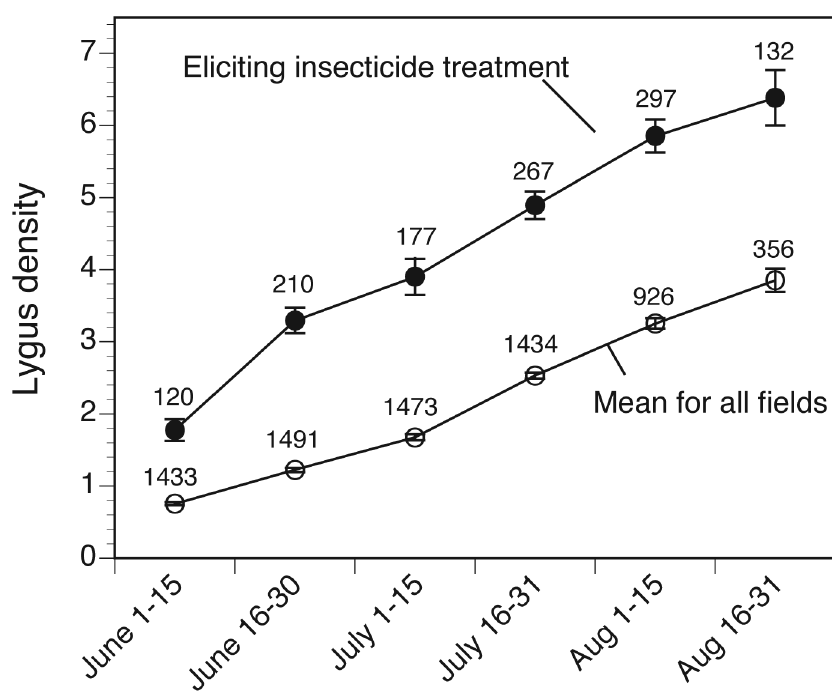
Figure 4. Insecticide use decisions and L . hesperus density. Mean ± SE density of L . hesperus that triggered the application of insecticides targeting L . hesperus (solid circles) during successive 2-week intervals during cotton’s fruiting period. Also shown for comparison are the mean L . hesperus densities observed across all fields (open circles). Numbers above the symbols are the number of fields for which density estimates were available. doi: